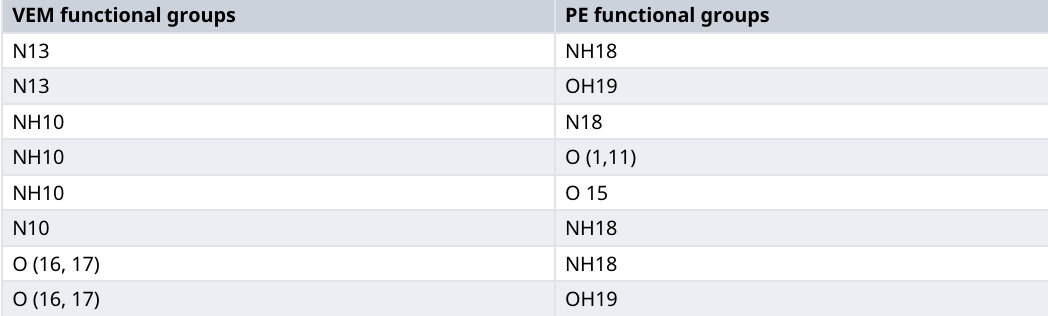
Table 1. VEM and phosphatidylethanolamine (PE) functional groups added as queries in ConQuest for intermolecular hydrogen bonding probabilities